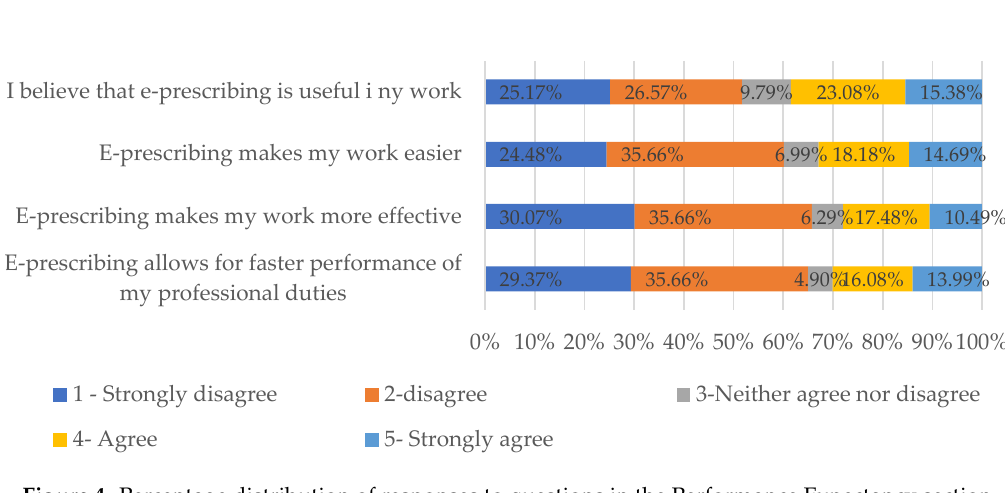
Figure 4. Percentage distribution of responses to questions in the Performance Expectancy section.